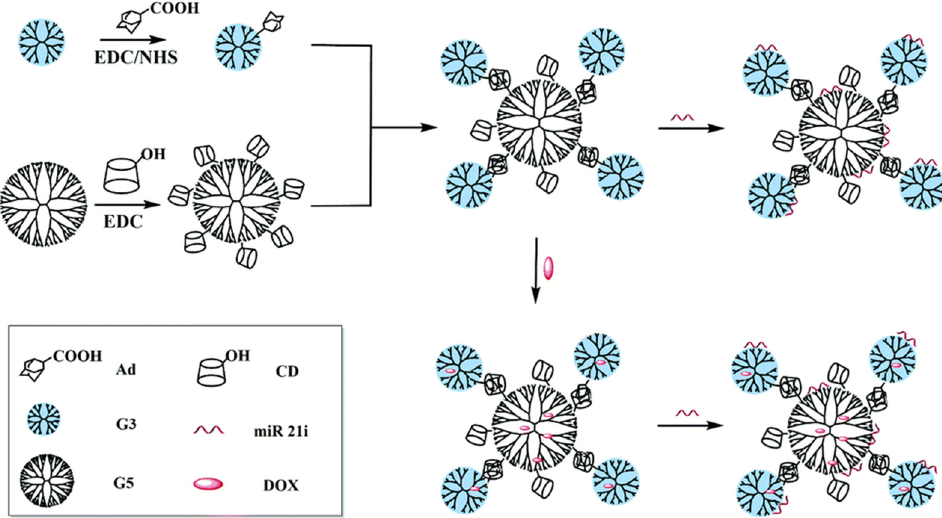
Figure 8. For use in drug delivery applications, G5-CD/G3-Ad CSTDs are synthesized to co-load DOX and miR 21i or to compress miR 21i (reproduced with permission of Royal Society of Chemistry from ref. [59]).